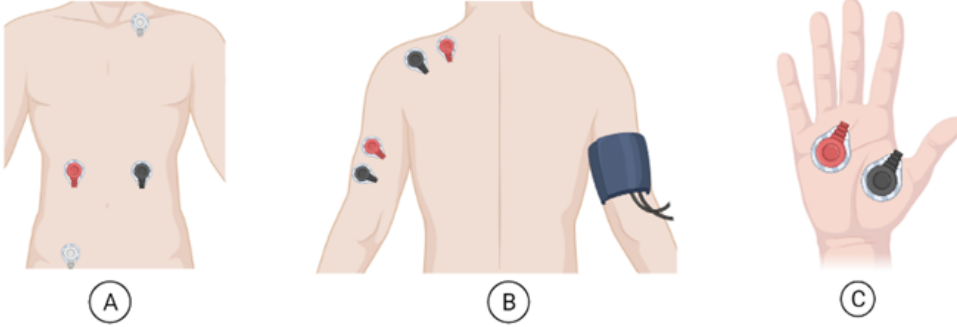
Figure 1. Illustration of the placement sites for the different electrodes ( A ) ECG electrodes plus reference electrode of the EMG; ( B ) EMG electrodes on the trapezius and triceps muscle plus BP monitor; and ( C ) EDA